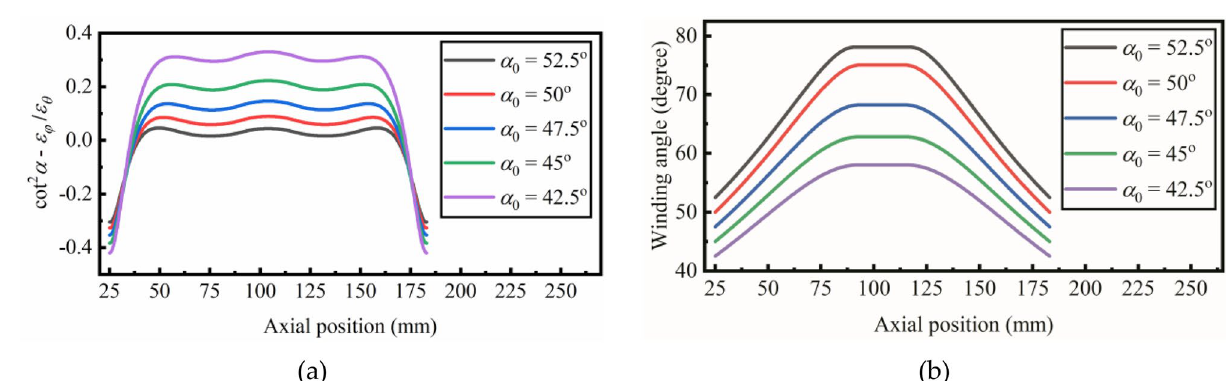
Figure 8. ( a ) The results of Eq. (29) with the initial winding angle increased from 42.5 degrees to 52.5 degrees. ( b ) The distribution of winding angle with the initial winding angle increased from 42.5 degrees to 52.5